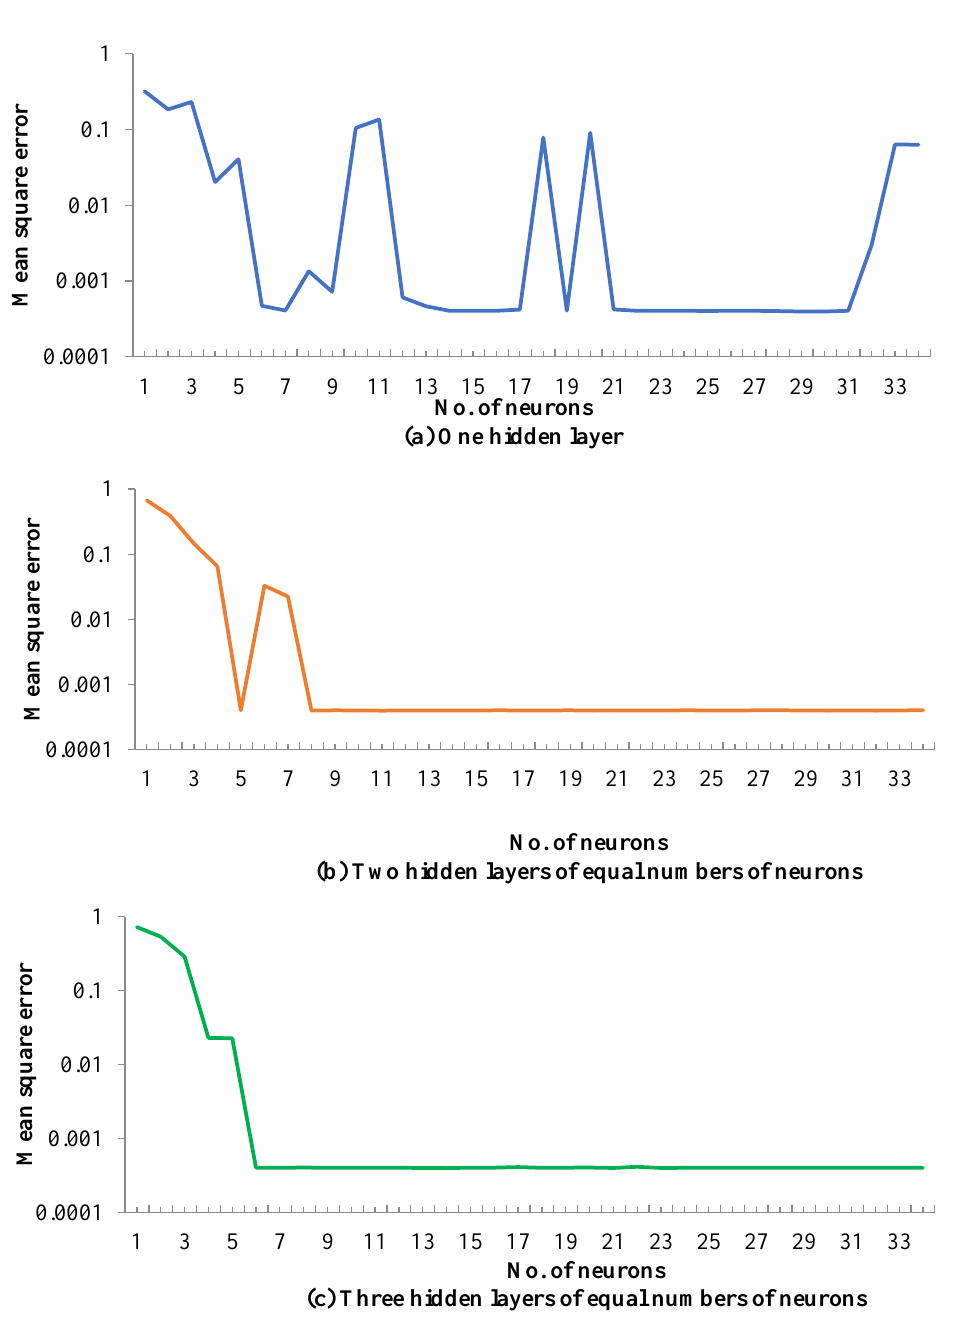
8 of 17 𝑥 𝑖 = 𝑥 𝑚𝑖𝑛 + (𝑥 𝑚𝑎𝑥 − 𝑥 𝑚𝑖𝑛 ) × 𝑥 𝑖,𝑃𝑟𝑒𝑑 (15) The tangent sigmoid transfer function for the hidden layer f(X) is given by Equation (16): 𝑓(𝑋) = 2 (1 + 𝑒 −2𝑛 ) − 1 = 𝑡𝑎𝑛 𝑠𝑖𝑔(𝑋) (16) Different topologies with one, two, and three hidden layer(s) and varying numbers of neurons (1 to 34) in hidden layer(s) were iteratively tested to achieve the optimum to- pology. The mean square error (MSE) was used to quantify the performance of the neural network topology according to Equation (17): 𝑀𝑆𝐸 = 1 𝑁 ∑(𝑦 𝑒𝑥𝑝,𝑖 − 𝑦 𝑝𝑟𝑒𝑑,𝑖 ) 2𝑁 𝑖=1 (17) The averages of the MSE values for all neural network topologies are presented in Figure 2. When using only one hidden layer, the levels of the MSE were higher than when using two or three hidden layers (Figure 2a). In addition, the unacceptable values of the MSE were estimated in different values of neurons. Using two hidden layers of an equal number of neurons produced lower values of the MSE than when using only one hidden